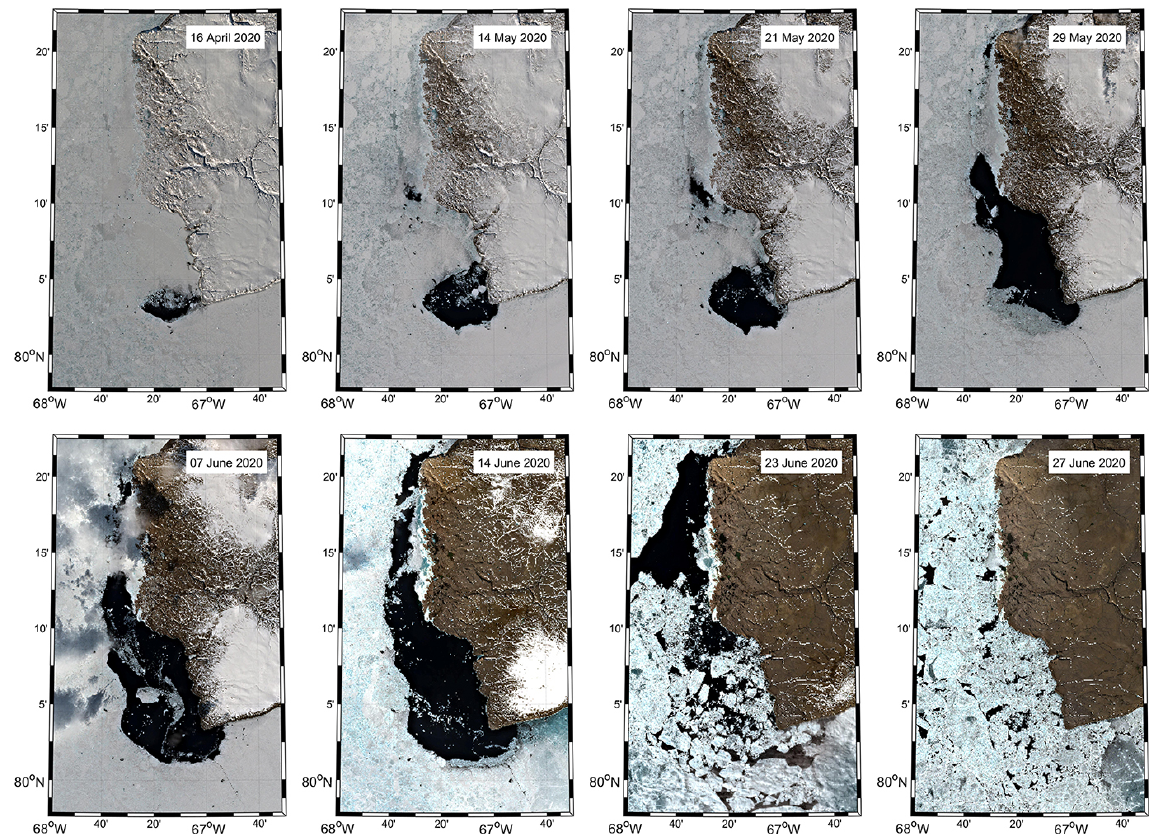
Figure 12. The evolution of polynya at Cape Jackson from April to June 2020 from Sentinel-2